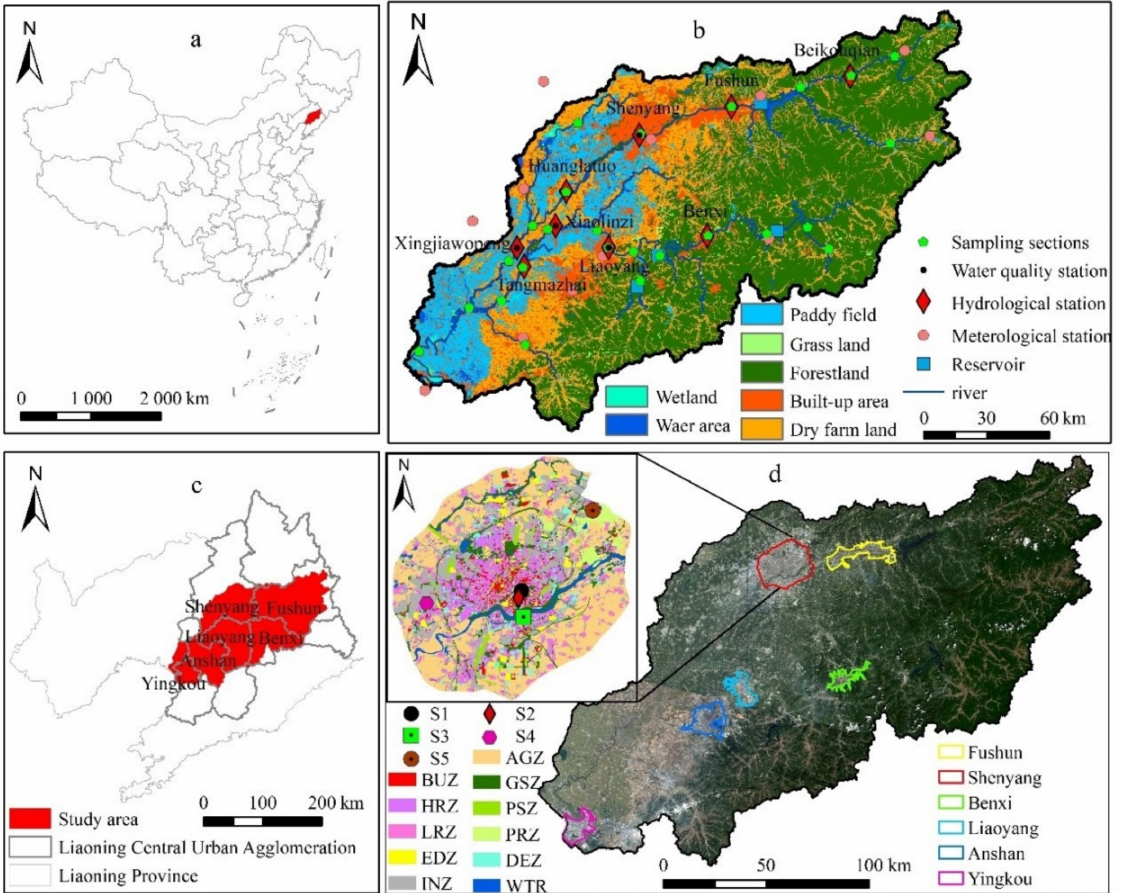
Figure 1. The Hun-Taizi River watershed and the built-up area in Liaoning Province, China. ( a ) China; ( b ) The land use map, meteorological, hydrological, water quality stations and sampling sections in the Hun-Taizi River watershed; ( c ) The distribution of the study area and the Central Liaoning Urban Agglomeration in Liaoning Province; ( d ) The built-up area of six cities and rainfall runoff sampling sites of different functional zones in Shenyang. Business zone (BUZ), high density residential zone (HRZ), low density residential zone (LRZ), educational zone (EDZ), industrial zone (INZ), agricultural zone (AGZ), green space zone (GSZ), public service zone (PSZ), preservation zone (PRZ), development zone (DEZ), and water (WTR); S1, S2, S3, S4 and S5 were the rainfall sampling sites in BUZ, EDZ, HRZ, INZ and PRZ,